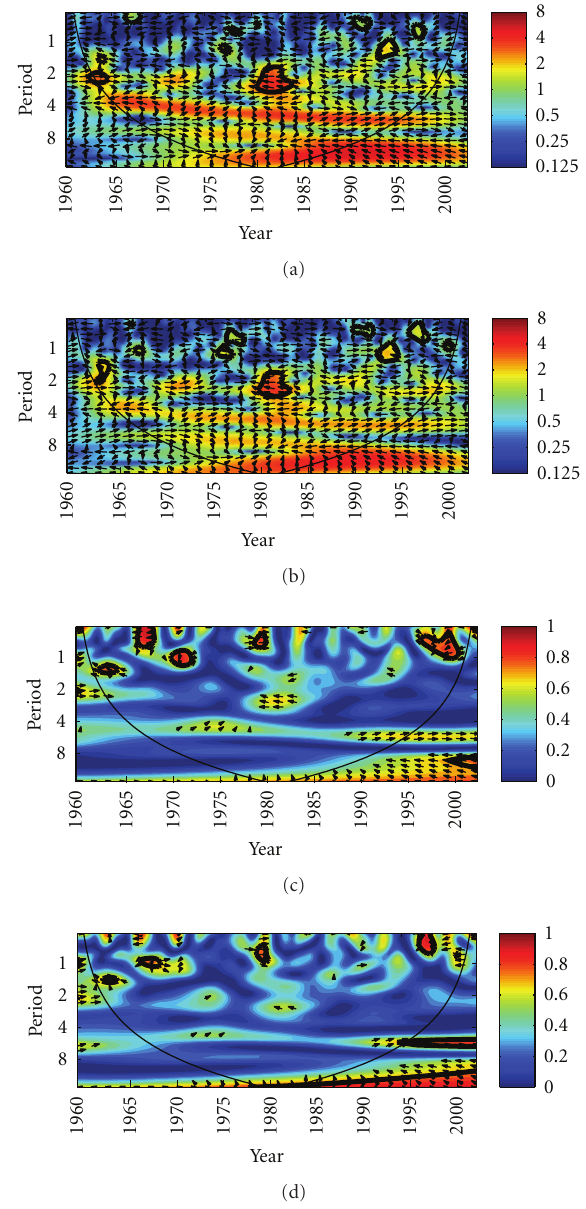
Figure 15: The wavelet cross-spectrum (a, b) and coherency spectrum (c, d) between the SOI and water temperature at 0 m and 100 m. The vectors indicate the phase di ff erence between the SOI and water temperature (with in-phase pointing right, antiphase pointing left, an arrow pointing vertically means the second time series lags the first by 90 ◦ , that is, the phase angle is 270 ◦ . The 5% significance level against red noise is shown as a tick contour, and the thin black line indicates the cone of the